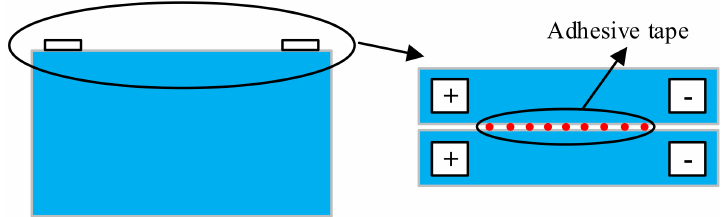
Figure 1. Schematic diagram of the heat-generation model for the lithium-ion battery.